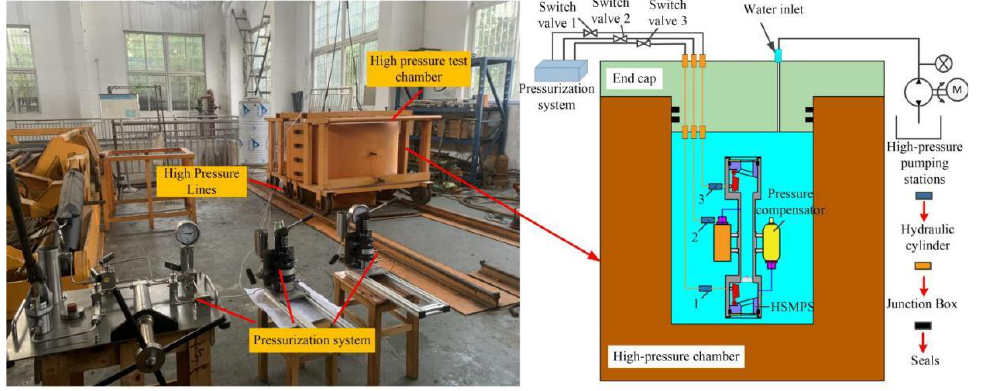
Figure 12. High pressure chamber test of HSMPS.